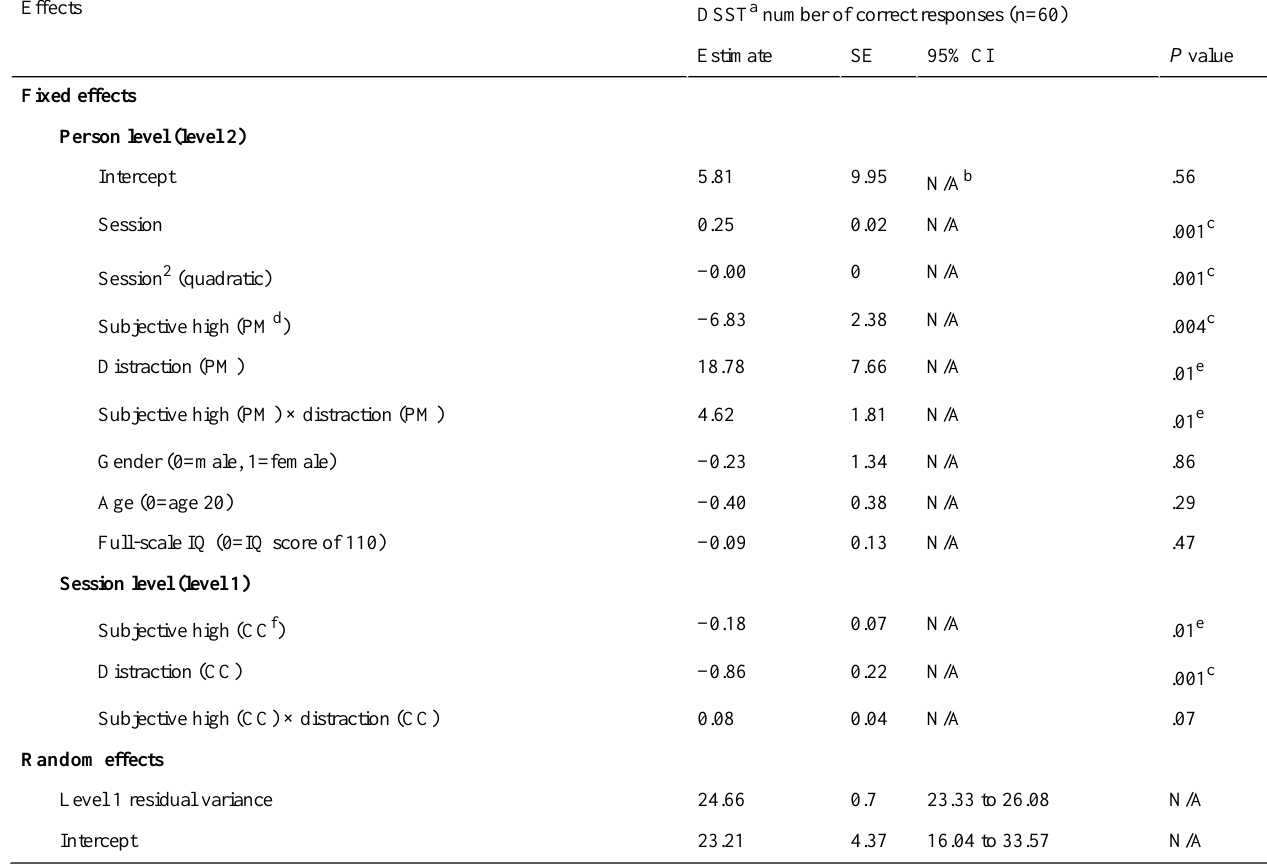
Table 8. Digit symbol substitution task: multilevel model of marijuana high in relation to number of correct